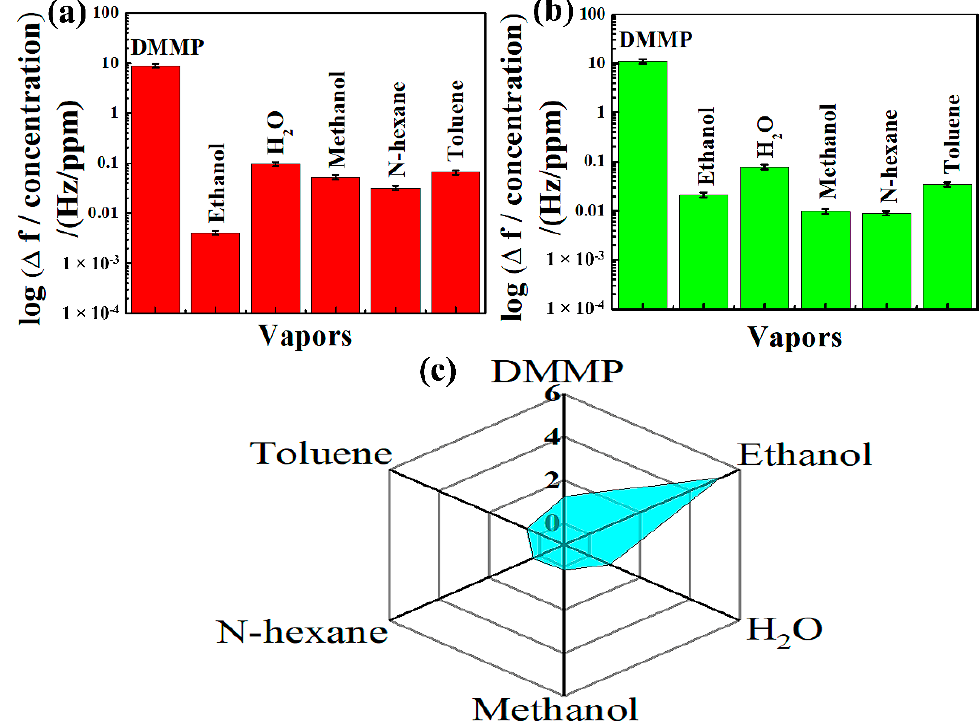
Figure 9. Selectivity of ( a ) NGO@MnO 2 , ( b ) NGO@MnO 2 /PPy in the SAW sensor, and ( c ) the polar plot of response ratios (R3/R4) between the NGO@MnO 2 /PPy-coated and NGO@MnO 2 -coated SAW ( T = 20 °C, R.H. = 25–30%).